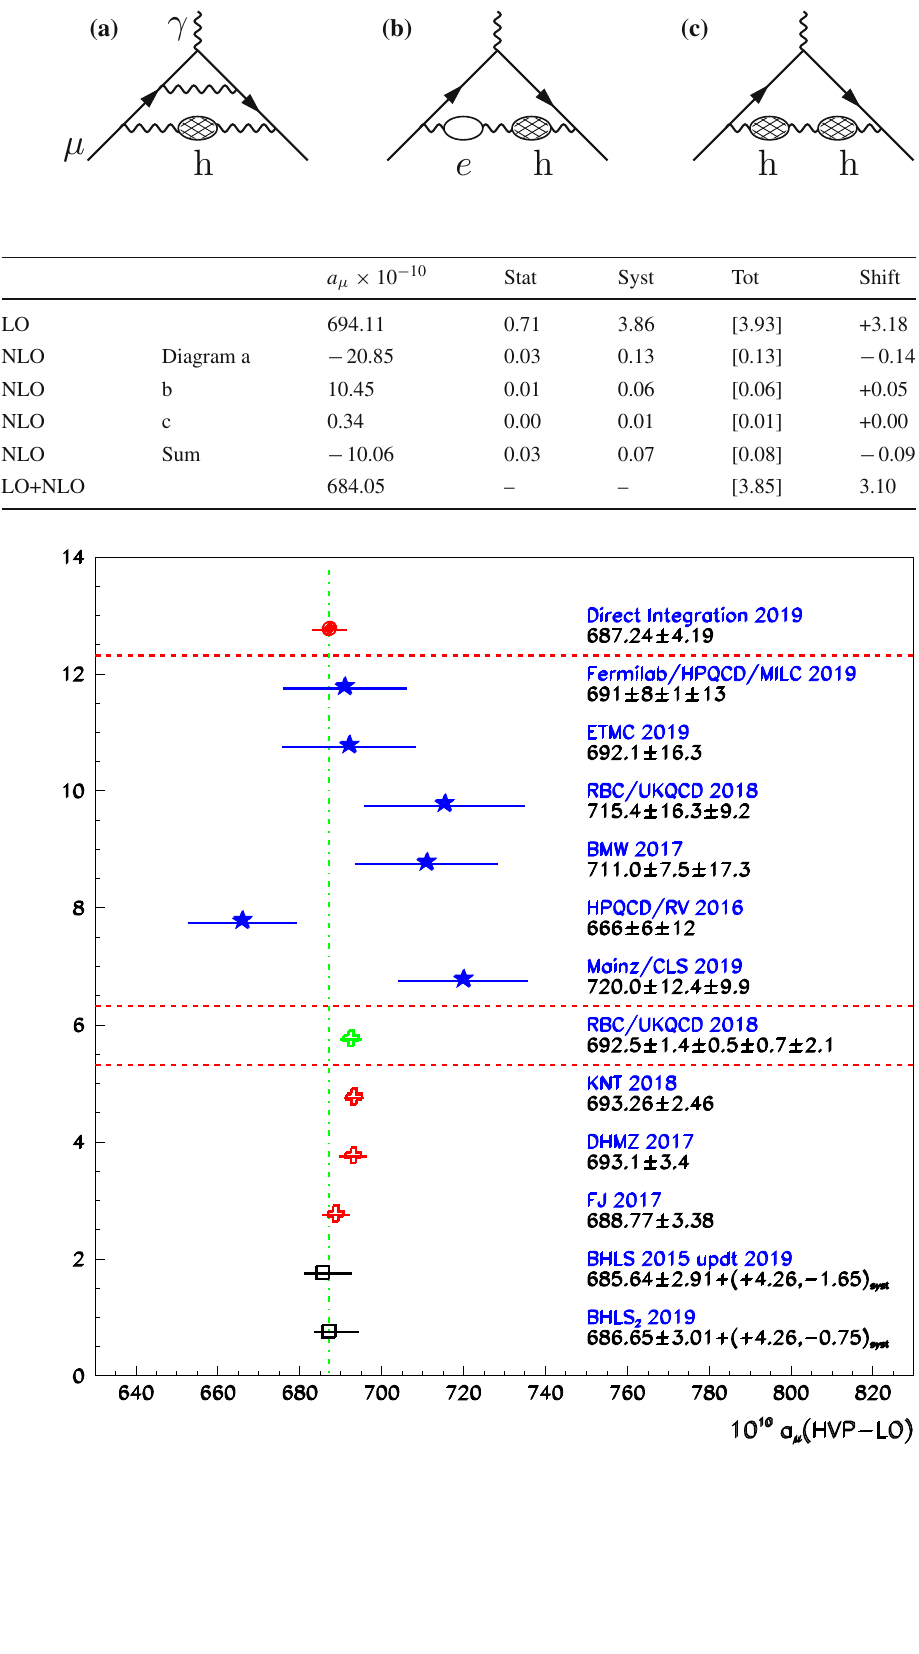
contributions to the hadronic VP; the shaded blob depicts the LO hadronic VP, the empty blob the LO leptonic VP